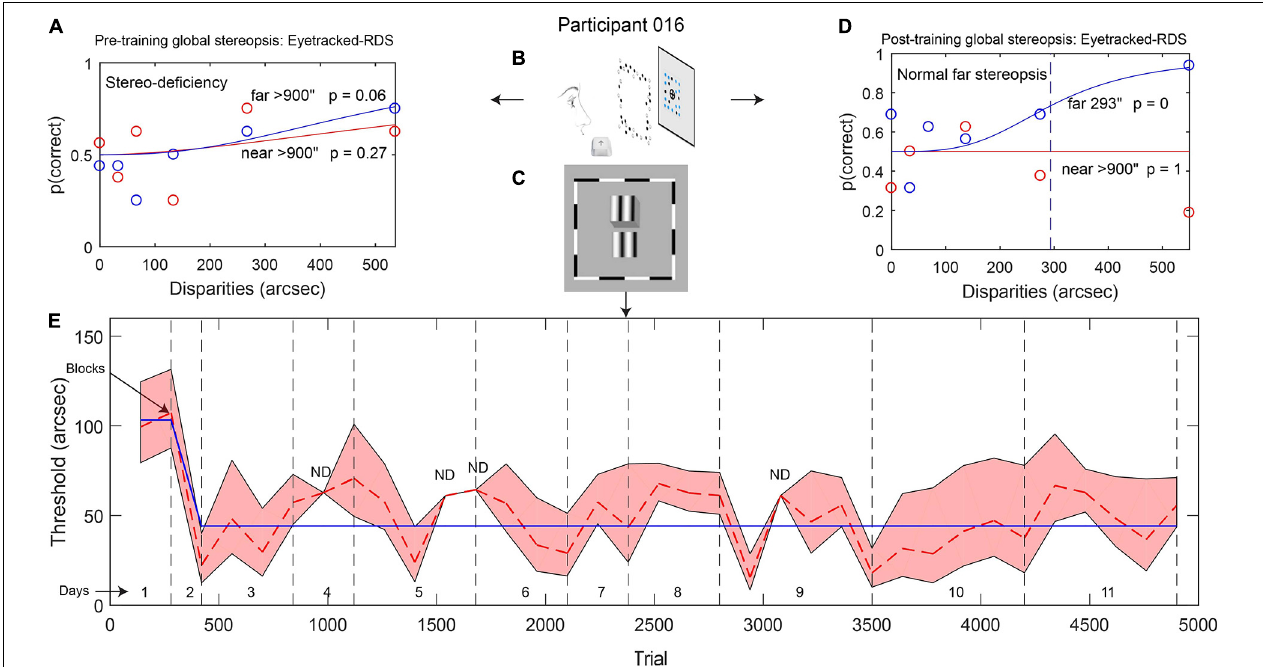
FIGURE 1 | (A,D) Example data from participant 016: psychometric functions showing global stereopsis performance before training ( A: stereo-deficiency) and after training ( D: normal stereopsis for far disparities) on the Eyetracked RDS task with a 200-ms stimulus presentation. The circles depict the proportion of correct trials for each relative disparity between target and background (red: near disparities, blue: far disparities). Red and blue continuous lines represent model fits (based on Eq. 1), and the dashed line indicates the threshold disparity value for far disparities after local stereopsis training. (B,C) Stimuli used for measuring global stereopsis ( B , Eyetracked RDS) and for training local stereopsis ( C , contour stereograms). (E) Local stereopsis thresholds across training trials. The red dashed line shows changes in thresholds that were calculated for each block of trials. Gray vertical dashed lines separate training days. The blue continuous line indicates thresholds from the best model (derived from Eq. 4). The red shaded area depicts the SEM (ND: SEM was not